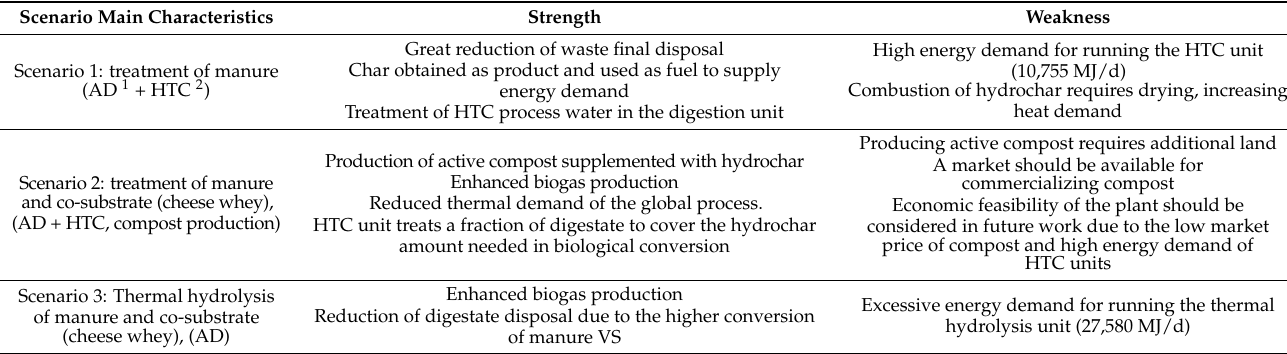
Table 5. Strengths and weaknesses of each scenario evaluated considering the use of digestion for producing biogas and the introduction of thermal treatment for digestate valorization (Scenario 1 and 2) or as a pre-treatment (Scenario 3). Scenario Main